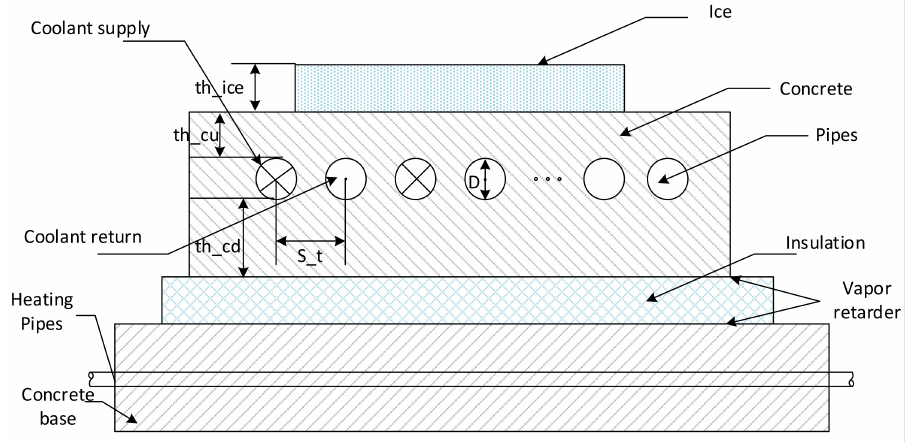
Figure 2. Cross section area of typical ice